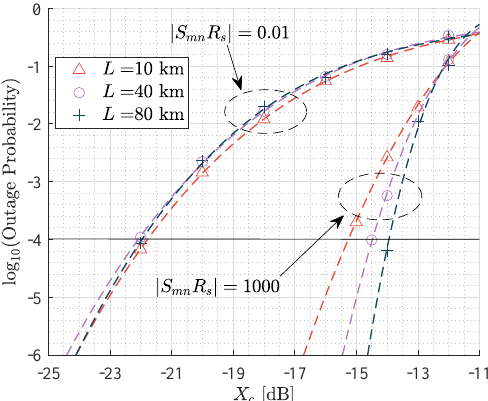
Figure 2. OP as a function of the ICXT level, for | S mn · R s | = 0.01 and | S mn · R s | = 1000, for r = 0.1 and one interfering core. The dashed lines represent a cubic interpolation of log 10 (OP).